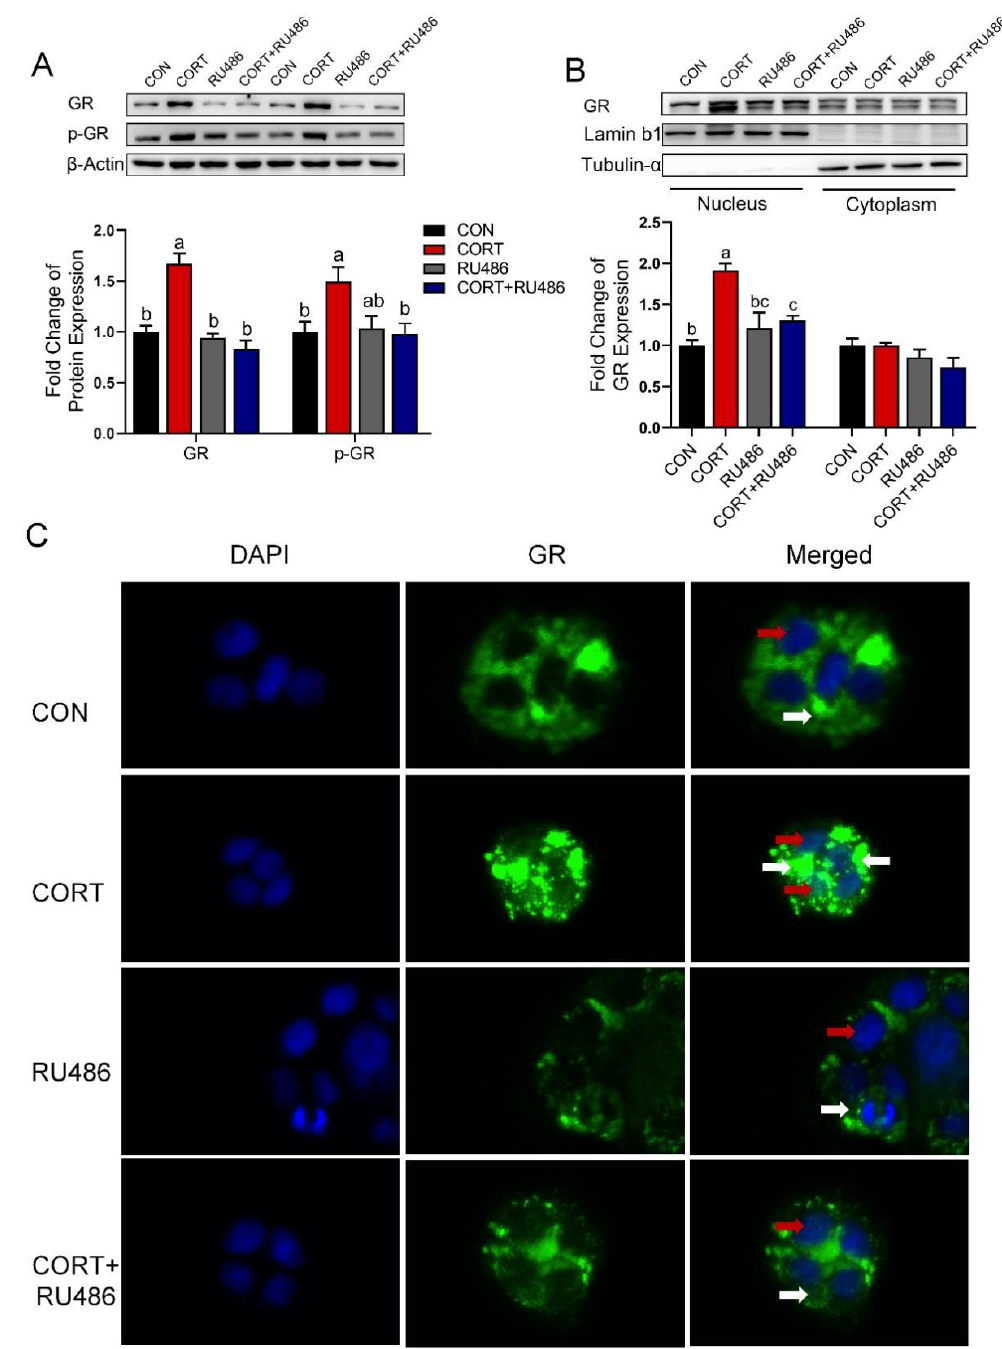
Figure 5. Corticosterone activates GR and promotes its entry into the nucleus in Caco-2 cells. (A) Western blot analysis of GR and p-GR protein expression in Caco- 2 cells with corticosterone (CORT, 10 μM) treatment in the presence and absence of GR antagonist RU486 (10 μM) for 24 h. (B) Western blot analysis of GR protein expression in nucleus and cytoplasm with corticosterone (CORT, 10 μM) treatment in the presence and absence of GR antagonist RU486 (10 μM) for 24 h. (C) Immunofluorescence analysis of GR pro- tein expression and localization in Caco-2 cells with c orticosterone (CORT, 10 μM) treatment in the presence and absence of GR antagonist RU486 (10 μM) for 24 h. n = 3, CON = control group; CORT = 10 μM corticosterone; RU486 = 10 μM mifepristone; CORT + RU486 = 10 μM corticosterone + 10 μM mifepristone. Values are means ± SEM. Different lowercase letters represent significant ( P < 0.05). Red arrow: distribution of GR in the nucleus. White arrow: distribution of GR in the cytoplasm.